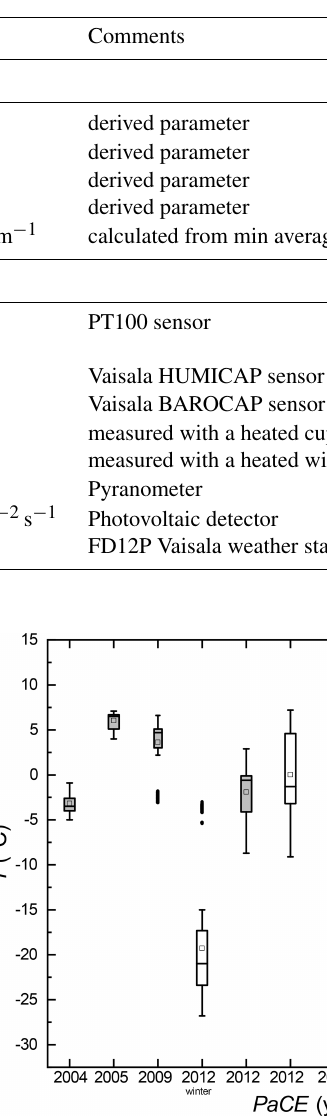
Table 2. Cloud properties and meteorological variables along with abbreviations and units as they are included in each data set.